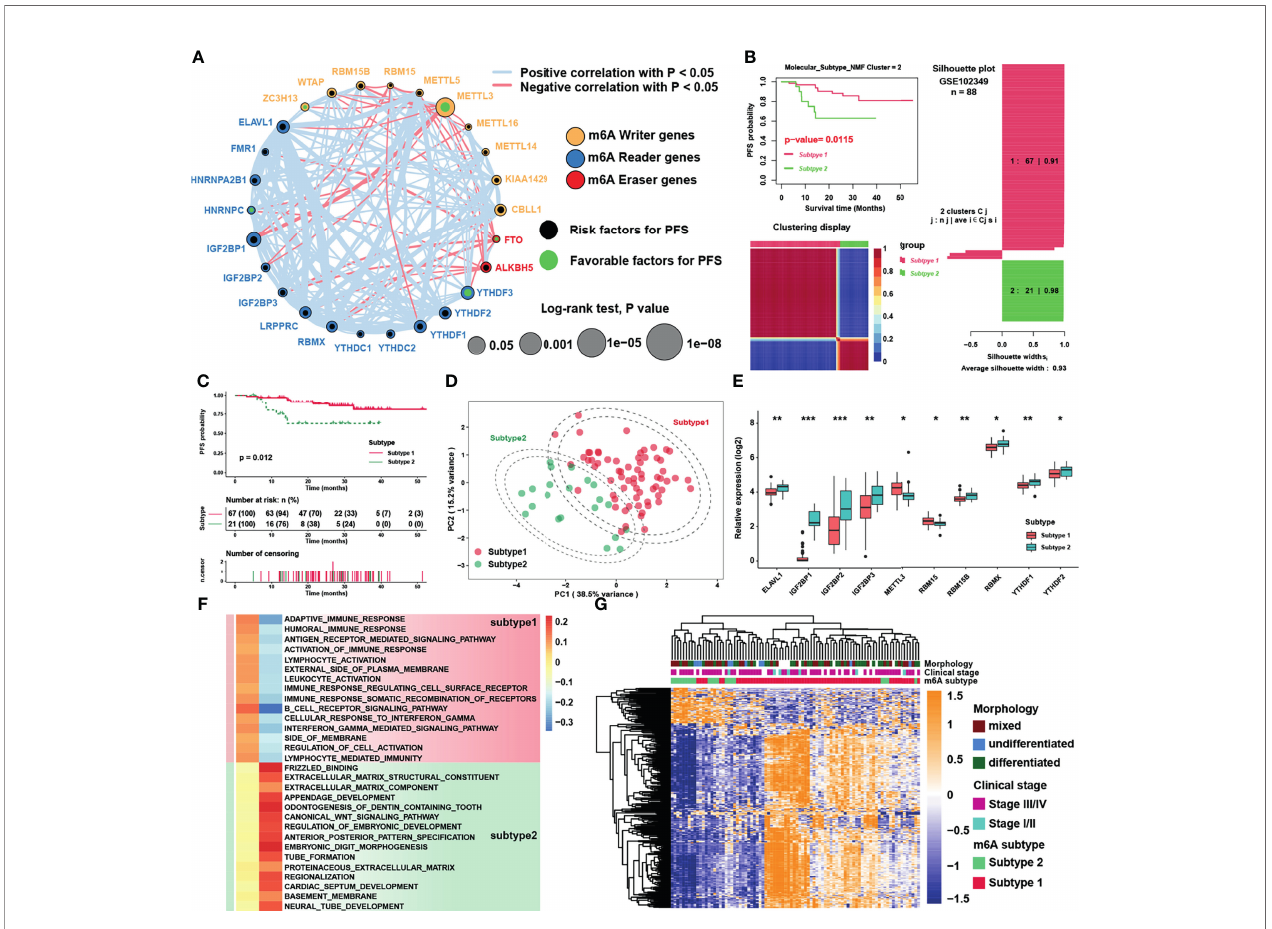
FIGURE 3 | Identi fi cation of m6A subtypes and biological function analysis. (A) The interaction among m6A regulators in NPC. The circle size represented the effect of each regulator on the prognosis, and the range of values was calculated by Log-rank test. Black dots and green dots in the circle represented risk and favorable factors of prognosis, respectively. The lines linking regulators showed their interactions, and thickness of lines showed the correlation strength. Negative correlation was marked with red and positive correlation with gray lines. (B) The result of NMF algorithm for k = 2 with the best average silhouette width 0.93. (C) Survival analysis for m6A subtypes in NPC. (D) Principal component analysis for the transcriptome pro fi les of m6A subtypes. The dashed circles represented 95% con fi dence interval. (E) Signi fi cantly different m6A regulators between two m6A subtypes. (F) GSEA analysis revealed distinct enriched gene sets between subtypes. In the heatmap, rows showed the selected 30 gene sets, and columns showed consensus scores for each subtype. (G) Heatmap of differentially expressed genes between subtypes 1 and 2, and m6A subtypes, clinical stage and morphology were used as patient annotations. The asterisks represented the statistical p-value (*P < 0.05; **P < 0.01; ***P < 0.001) in panel (E)